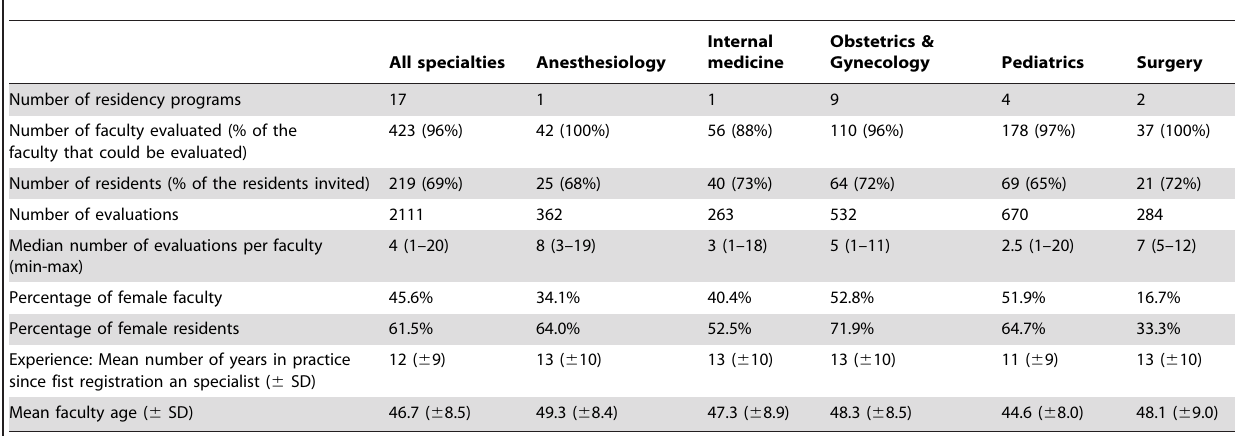
Table 1. Characteristics of study